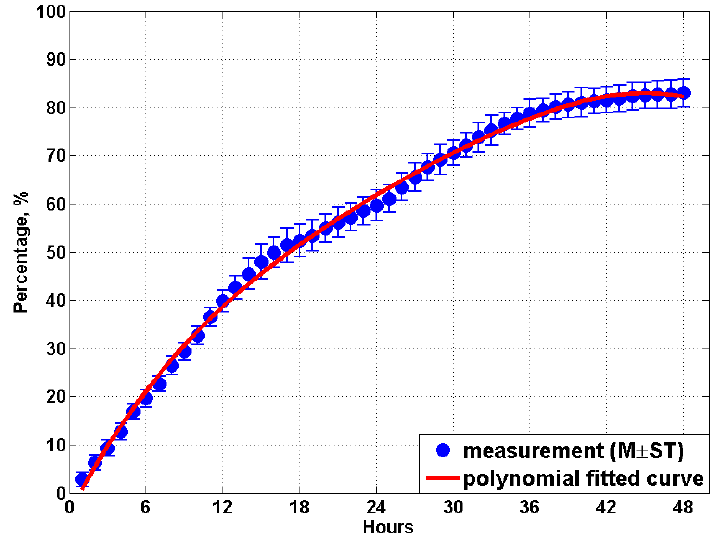
Figure 8. The measured manure coverage proportion curve with time and the polynomial fit curve within 48 h. Mean values (M) and standard deviations (ST) are calculated based on all 21 weeks’ data.